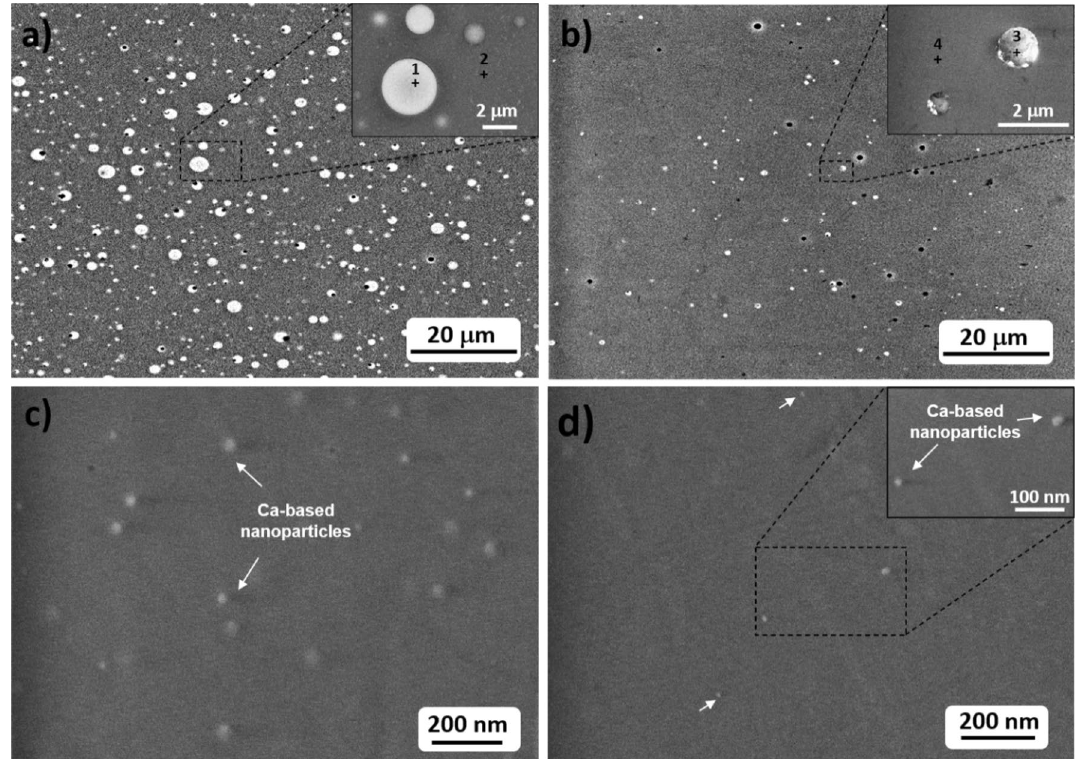
Figure 1. SEM micrographs of the core of: ( a ) preform A, ( b ) preform B, ( c ) preform C, ( d ) preform D. The inset of ( a ) and ( b ) shows an enlargement of the marked area in the corresponding core micrograph, showing in